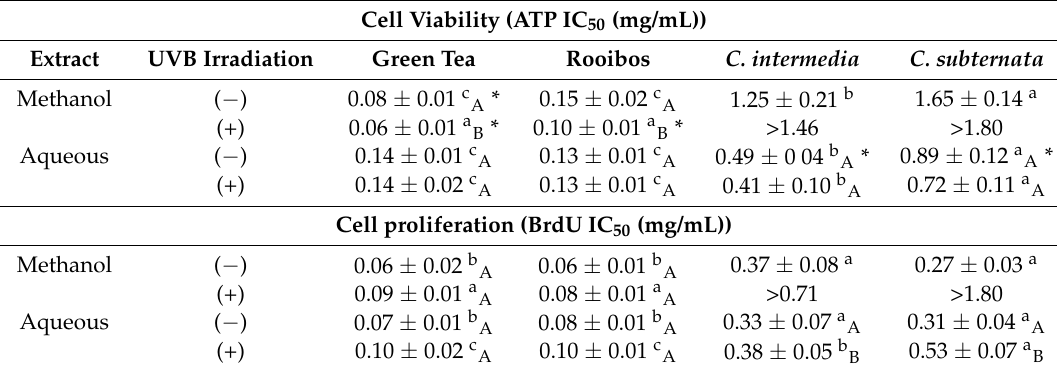
Table 1. Comparative effect of green tea and herbal tea extracts on growth parameters of UV irradiated and non-irradiated HaCaT